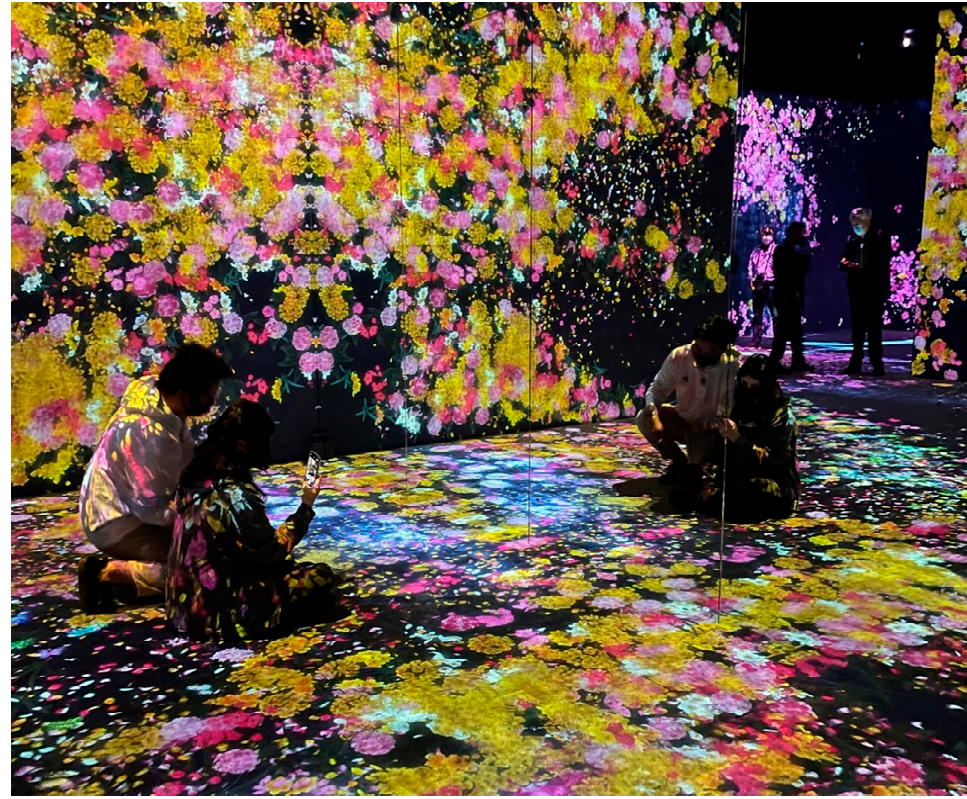
Figure 14. teamLab, Forest of Flowers and People: Lost, Immersed and Reborn (“hashtag art”), 2017/2021, Asian Art Museum of San Francisco; photograph by the author, 2022.